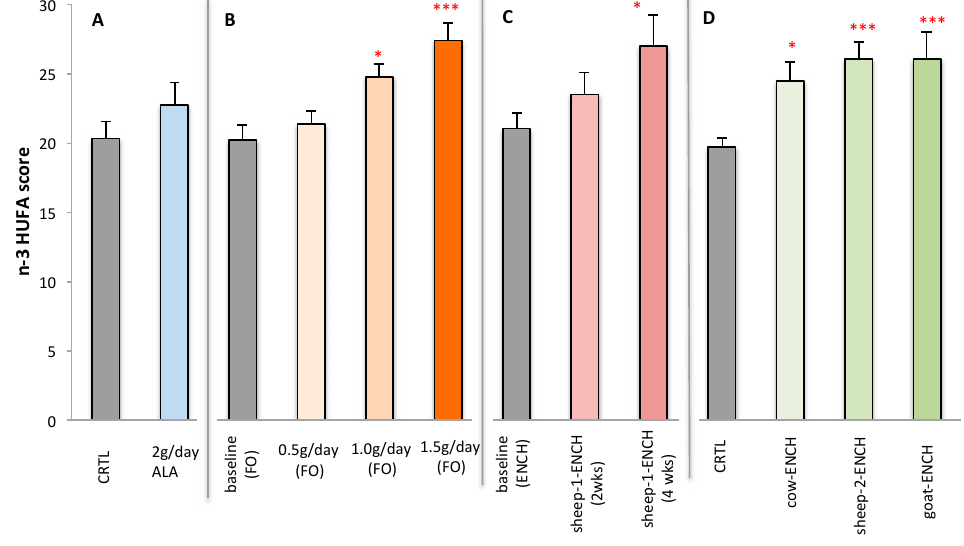
Figure 4. Plasma n-3 HUFA scores of subjects administered different treatments: ( A ) CRTL control (4 g/day olive oil) and 4 g/day linseed oil (~2 g of ALA), n = 12/group; ( B ) 0.5 g/day, 1.0 g/day and 1.5 g/day of FO for 2wo weeks, n = 15/group; ( C ) 90 g/day of sheep-1-ENCH cheese for two and four weeks, n = 15/group; ( D ) 50 g/day of different ENCH or CRTL cheeses for two months, n = 36/group. The data are expressed as mean ± SEM per group; * p < 0.05; *** p < 0.001 versus baseline (time 0) or control group.